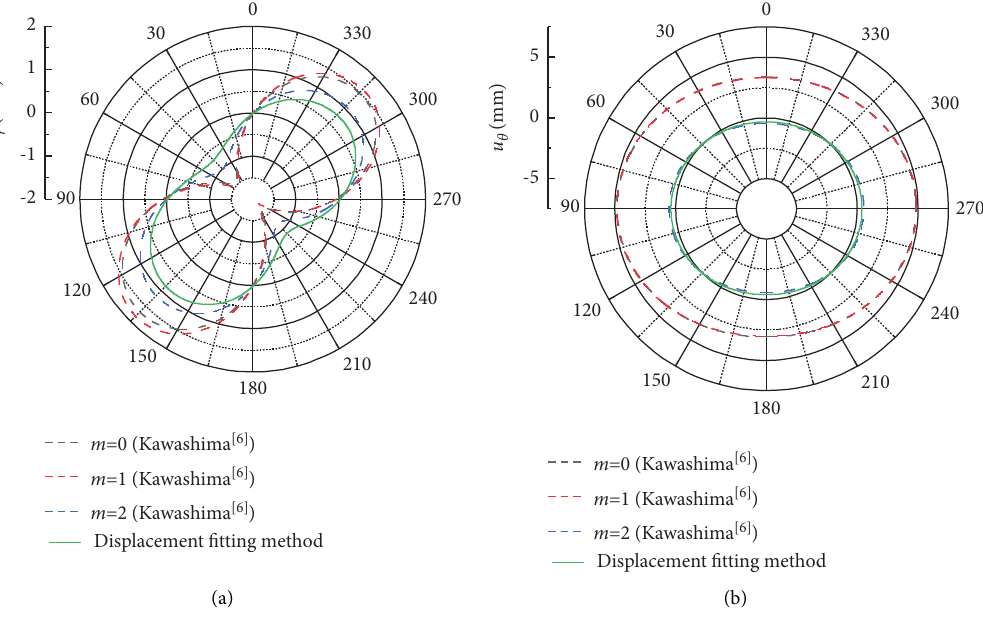
Figure 13: Results of displacement. (a) Radial displacement; (b) tangential